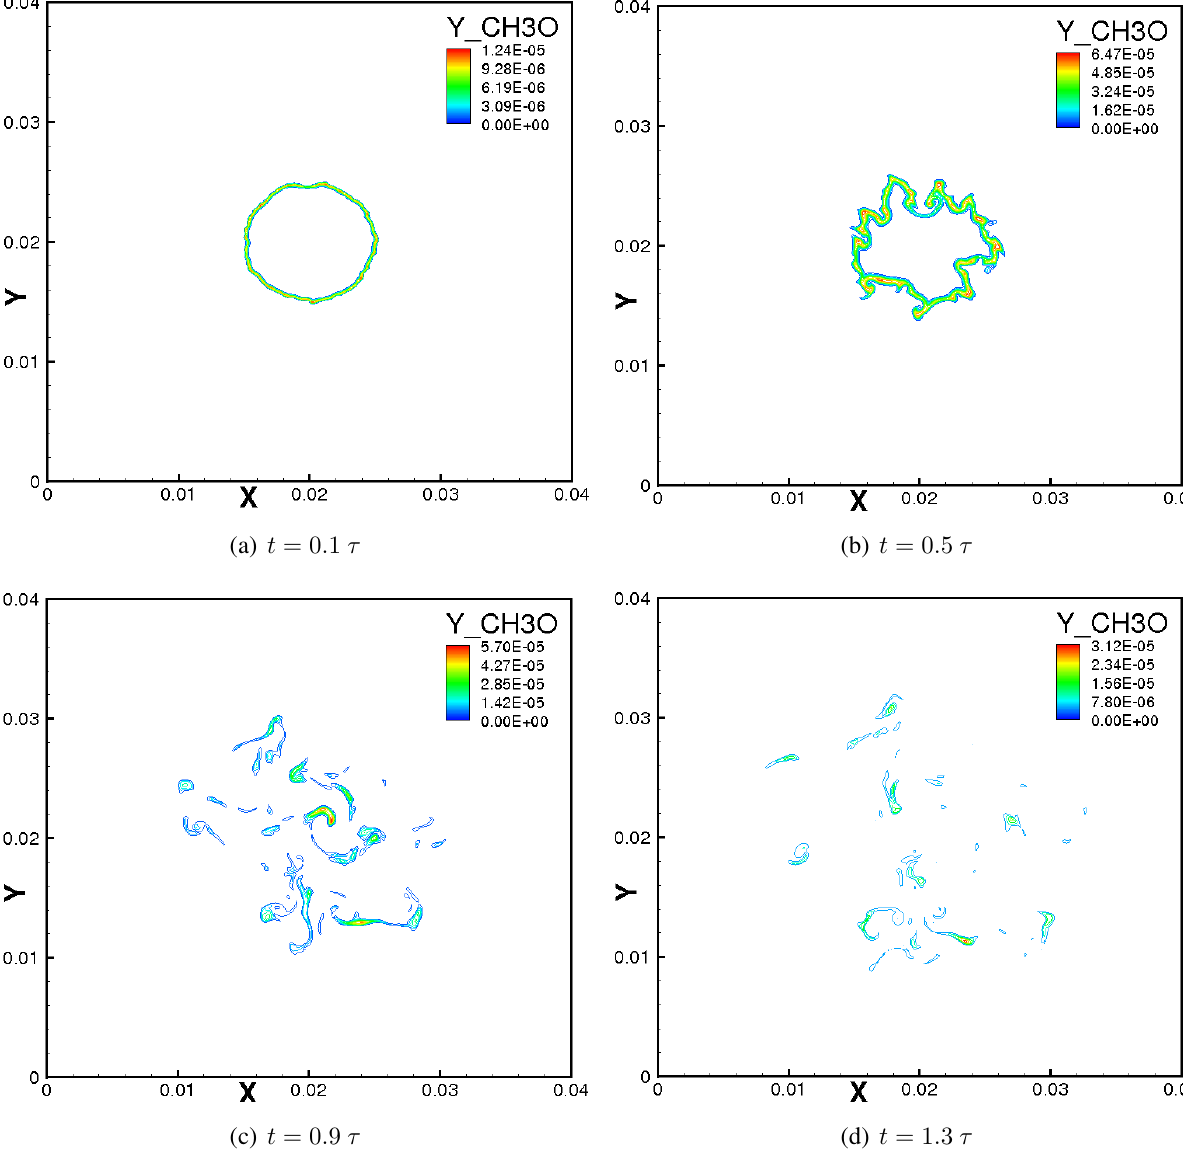
Figure 3. Time evolution of the iso-contours of the mass fraction of CH